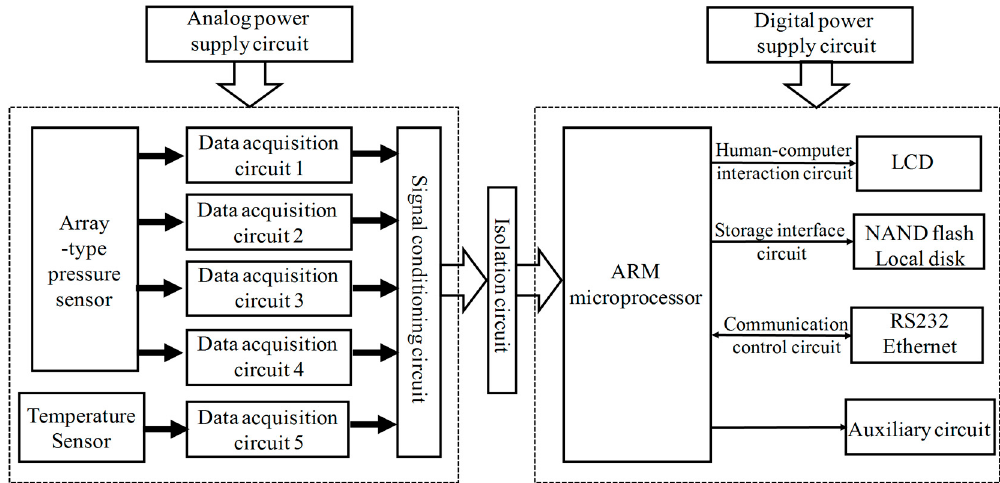
Figure 11. The systematic block diagram for hardware implementation of the array-type MEMS intelligent pressure sensor system.